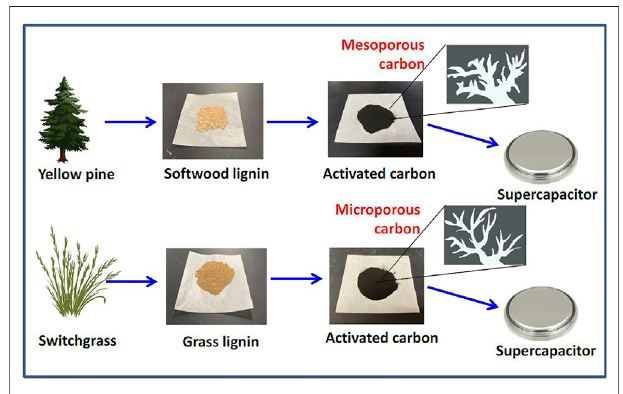
FIGURE 1 | Schematic diagram for illustrating the fl owchart of supercapacitor using two kinds of electrode materials, where activated carbons were derived from different raw materials and lignin